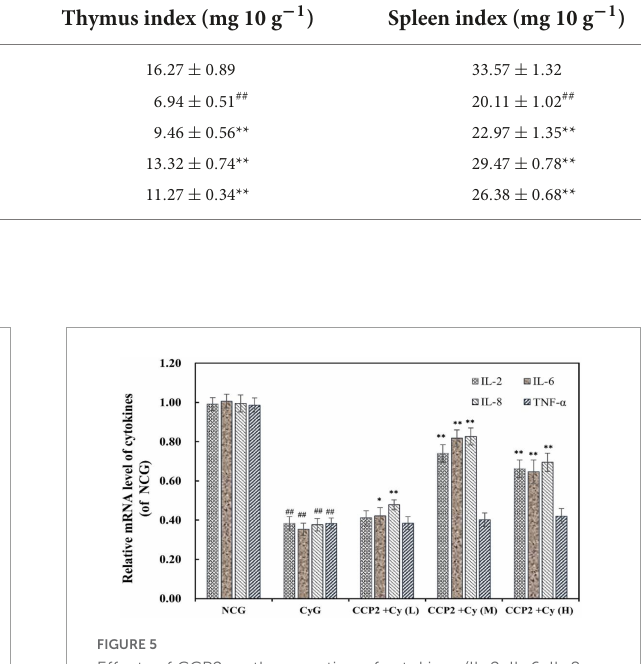
FIGURE5 Effects of CCP2 on the secretion of cytokines (IL-2, IL-6, IL-8, and TNF- α ) in the peritoneal macrophage of immunosuppressive mice induced by Cy. RT-qPCR analysis was relative to that of the reference gene (GAPHD). NCG: Normal control group, CyG: Cyclophosphamide treatment group, CCP2 + Cy (L): Cy + CCP2 treatment group (100 mg kg − 1 day − 1 ), CCP2 + Cy (M): Cy + CCP2 treatment group (200 mg kg − 1 day − 1 ), CCP2 + Cy (H): Cy + CCP2 treatment group (400 mg kg − 1 day − 1 ), ## p < 0.01 vs. the NCG group, ∗ p < 0.05, ∗∗ p < 0.01 vs. the CyG group. Data were expressed as mean ± SD, n =